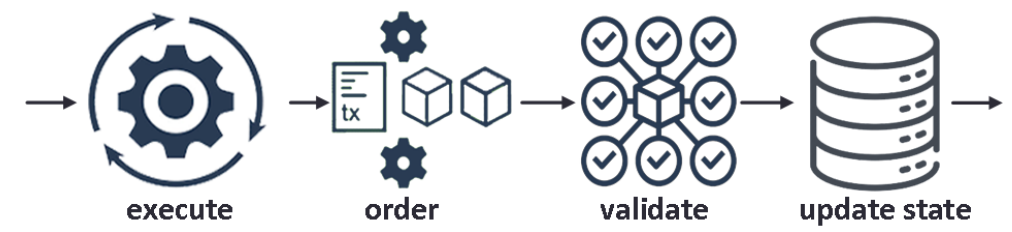
Figure 4. The transaction flow in Hyperledger